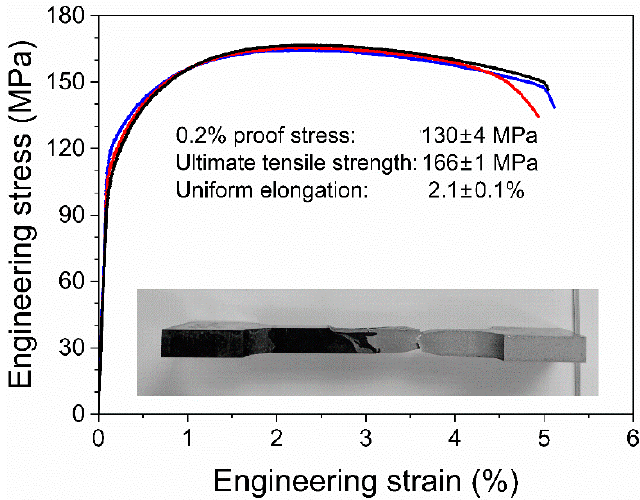
Figure 8. Stress–strain curves and average parameters of strength and elongation. Optical micrograph shows a tested specimen machined from the welded plate used for microstructural characterization and hardness measurements.